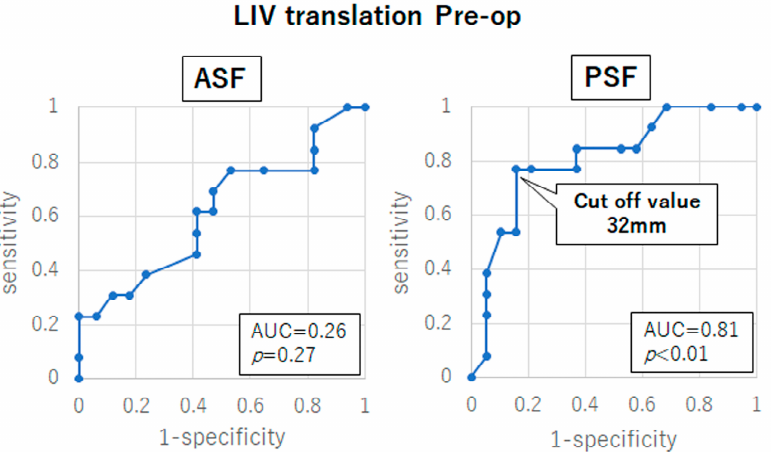
Figure 3. Receiver-operating characteristic (ROC) curve of the preoperative lowest instrumented vertebra (LIV) translation of ≤ 12 mm at the final follow-up in the anterior spinal fusion (ASF) and the posterior spinal fusion (PSF) groups. AUC indicates area under the ROC curve.